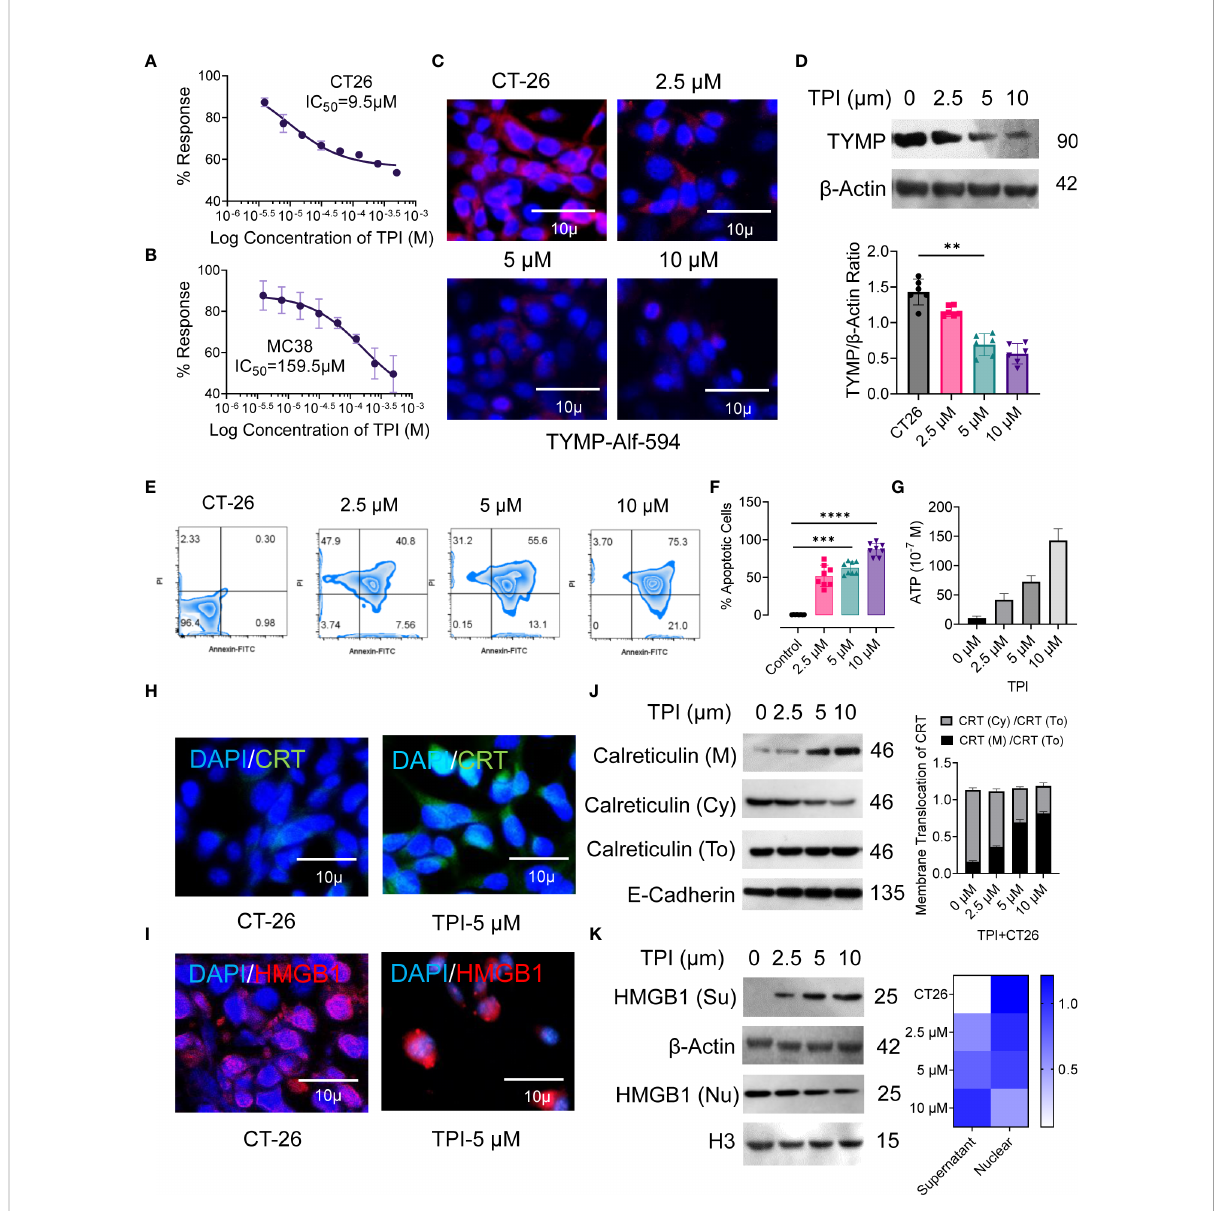
FIGURE 3 Inhibition of thymidine phosphorylase (TYMP) in vitro with tipiracil hydrochloride (TPI) potentiating cytotoxicity and ICD induction in colorectal cancer cells. The in vitro antiproliferative effects of TPI were studied using a 48-h exposure of the murine colon cancer cell lines (A) CT-26 and (B) MC-38. (C) CT-26 tumor cells were treated with increasing concentrations of TPI for 8 h at 37°C and 5% CO 2 . The cells were washed in PBS (×2), stained with PE-labeled anti-TYMP antibody for 2 h and observed under a microscope (Leica DMi8). A representative image of 3 similar experiments is shown. (D) TYMP expression in untreated and TPI-treated CT-26 cells was examined by Western blot. b -actin was reblotted as a loading control. (E, F) Annexin V staining for the assessment of percent apoptosis in CT-26 tumor cells in the presence of varying concentrations of TPI. Representative zebra plot of eight independent experiments. (G) ATP release by dying tumor cells is the hallmark of ICD. ATP release into the supernatant of CT-26 cells treated with TPI (mean ± SD, n=4). (H, I) Translocation of CRT from the cytosol/ER (Cy) to the cell surface (M) and relocalization of HMGB1 from the nucleus of CT-26 cells after incubation with or without TPI (5.0 µM). (J, K) Western blot analysis of membrane CRT and nuclear (nu) and extracellular (Su) localization of HMGB1 in CT-26 cells after treatment with varying concentrations of TPI. Western blot gray value of HMGB1 and CRT protein intensity (n = 6 independent replicates). For the violin plot, the middle line is the median, the lower and upper hinges correspond to the fi rst and third quartiles, and lover and upper adjacent values represent ±1.5 interquartile ranges. Mean densiometric quanti fi cation of bands as indicated (column-scaled z scores) fractions for HMGB1. The color scale indicates the relative expression levels. Unless otherwise noted, the data are presented as independent biological triplicates. In vivo studies were repeated independently fi ve times to con fi rm the results. **p < 0.01, ***p < 0.001, and ****p <